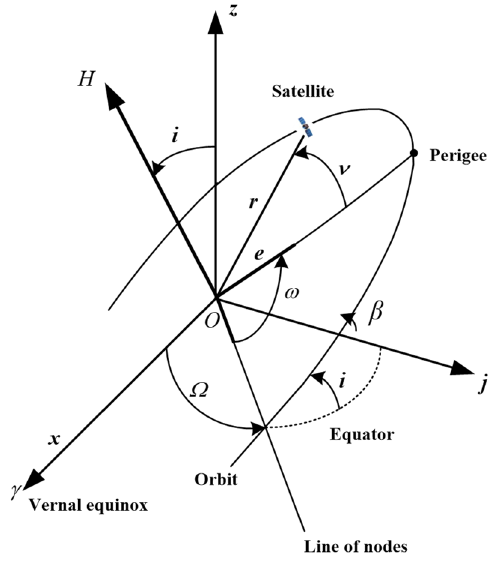
Figure 3. Keplerian elements. Figure 3. Keplerian